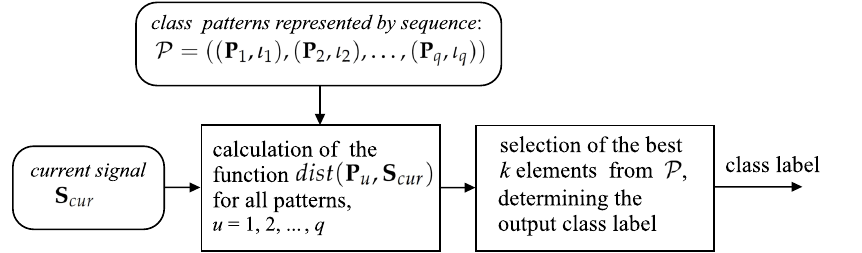
Figure 3. Simplified flowchart of the kNNModel method and data structures utilized in the implementation of this